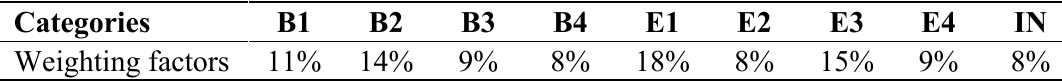
Table 4. Default weighting